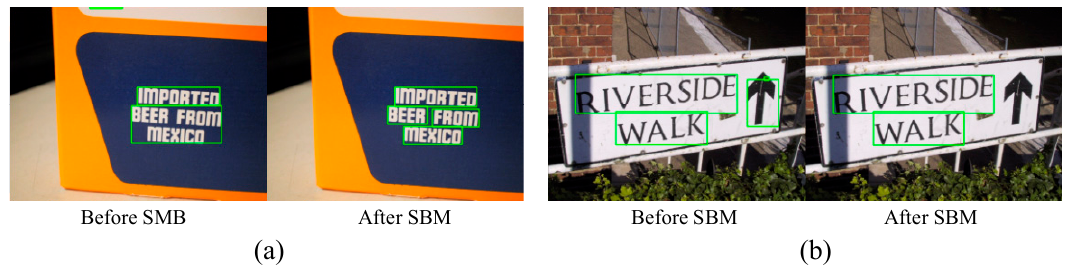
Figure 7. Examples of CRF processing effects. ( a ) Two lines of text are placed in one bounding box. After CRF processing, each word has a separate bounding box. ( b ) The arrow is erroneously detected as text and the arrow bounding box is removed after CRF processing.